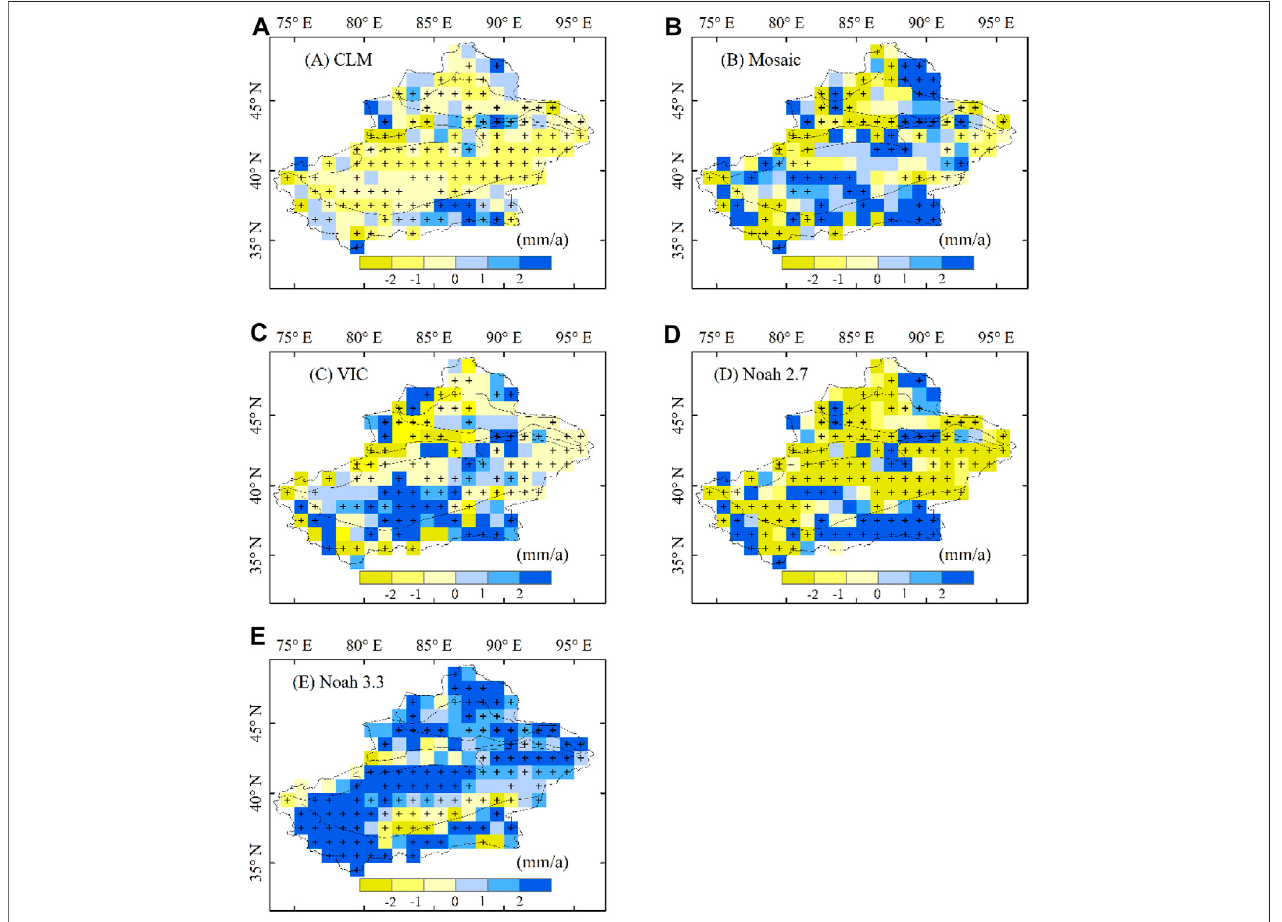
FIGURE 9 | Same as Figure 4 , but for DJF soil